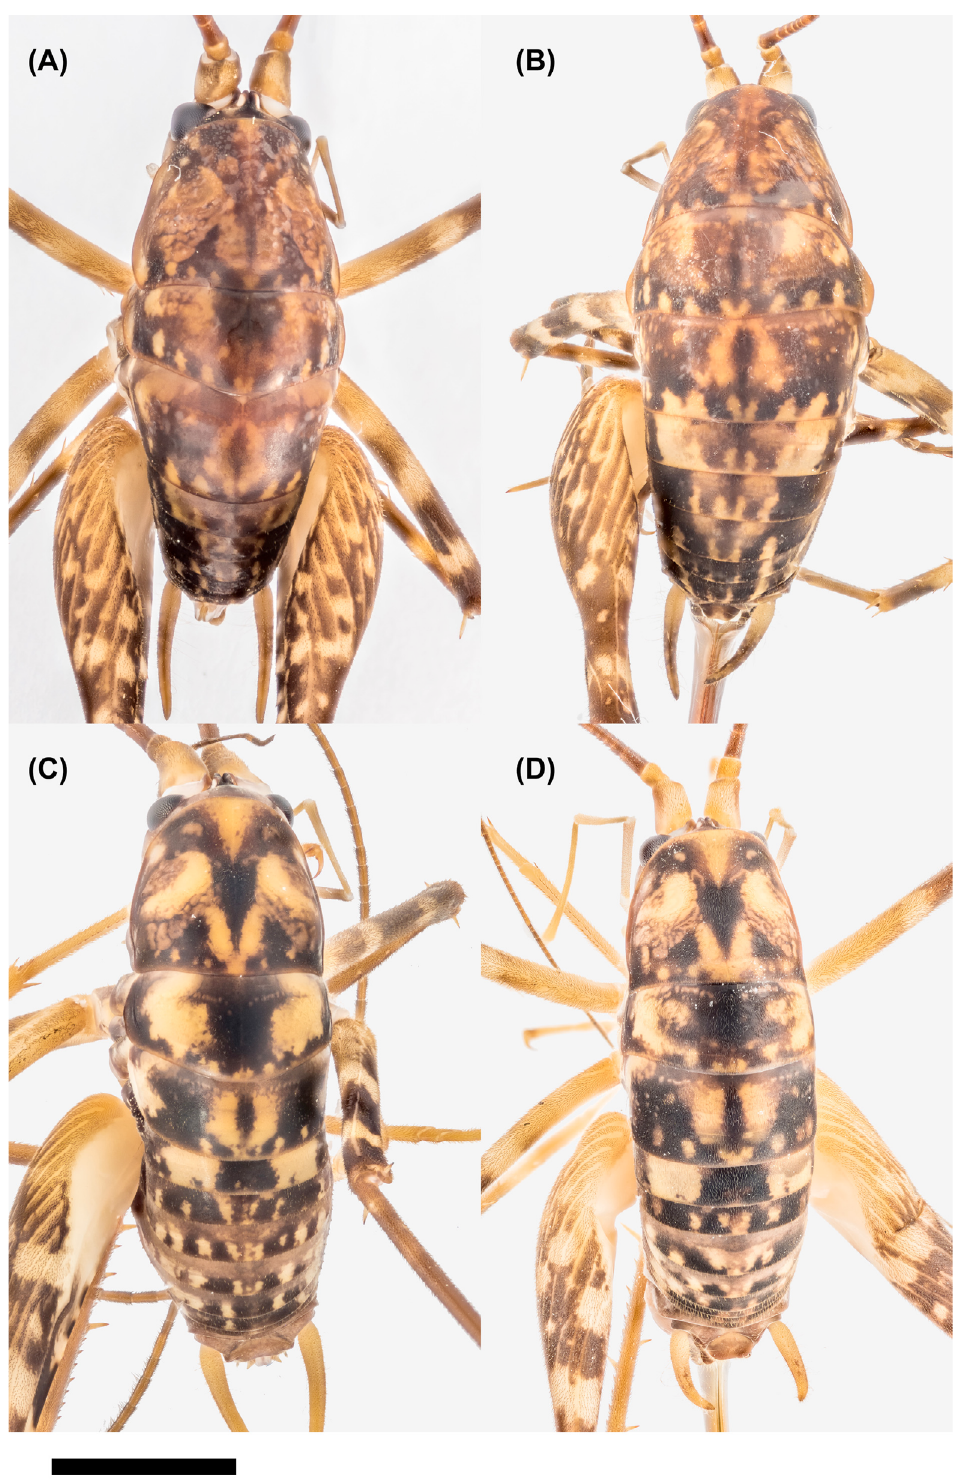
Fig. 6. Dorsal views of cave wētā in the genus Miotopus hutton, 1898. A–B . Miotopus diversus (hutton, 1896). A . Adult ♂, Resolution Bay, Queen Charlotte Sound (MPN CW3601). B . Adult ♀, Camp Bay, Queen Charlotte Sound (MPN Cw3596). C–D . Miotopus richardsi sp. nov. C . Adult ♂, Lewis Pass (MPN Cw3609). D . Adult ♀, Borland Road, Fiordland NP (MPN CW3811). Scale bar = 5